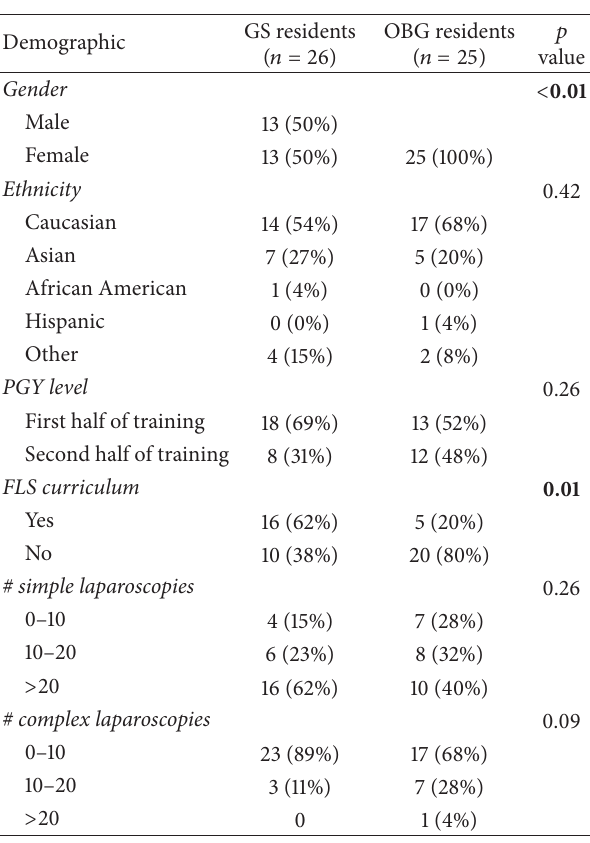
Table 1: Demographics.